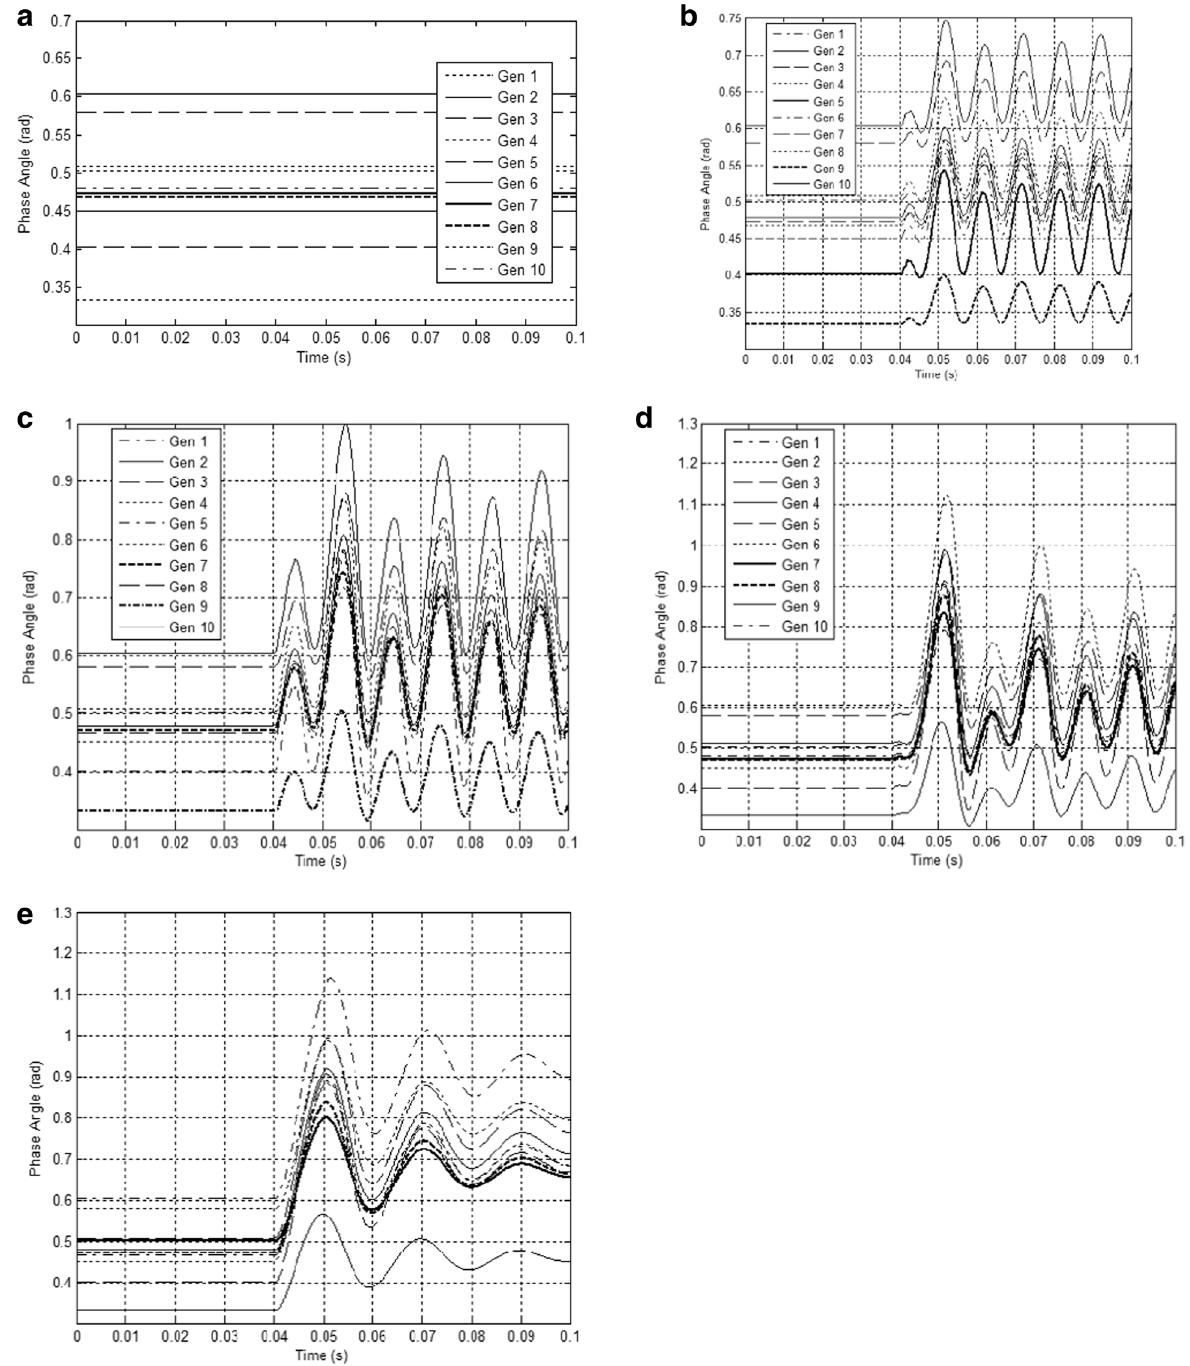
Fig. 12 a . EPFA variation during no-fault condition in IEEE-39 bus system. b . EPFA variation during LG-fault (AG) condition at branch 3 – 18, 50 km away from bus-3 with FR = 0 Ω and FIA = 0° in IEEE-39 bus system. c . EPFA variation during LL-fault (BC) condition at branch 4 – 5 20 km away from bus-4, with FR = 10 Ω and FIA = 45° in IEEE-39 bus system. d . EPFA variation during LLG-fault (CAG) condition at branch 23 – 24, 70 km away from bus-23 with FR = 100 Ω and FIA = 120° in IEEE-39 bus system. 12 e . EPFA variation during LLL-fault (ABC) condition at branch 5 – 6, 50 km away from bus-5 with FR = 0 Ω and FIA = 0° in IEEE-39 bus